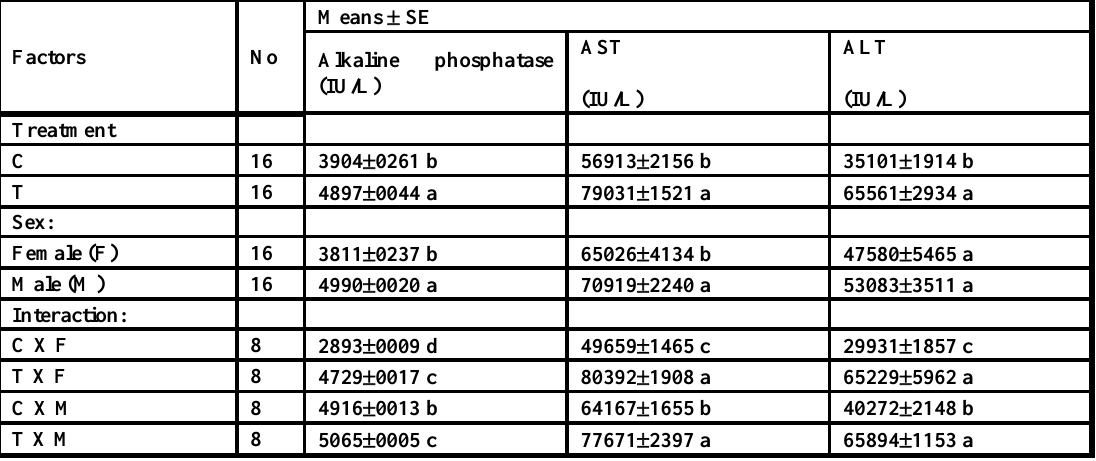
Table 2 Effects of Nigella sativa oil on Alkaline phosphatase, AST and ALT in